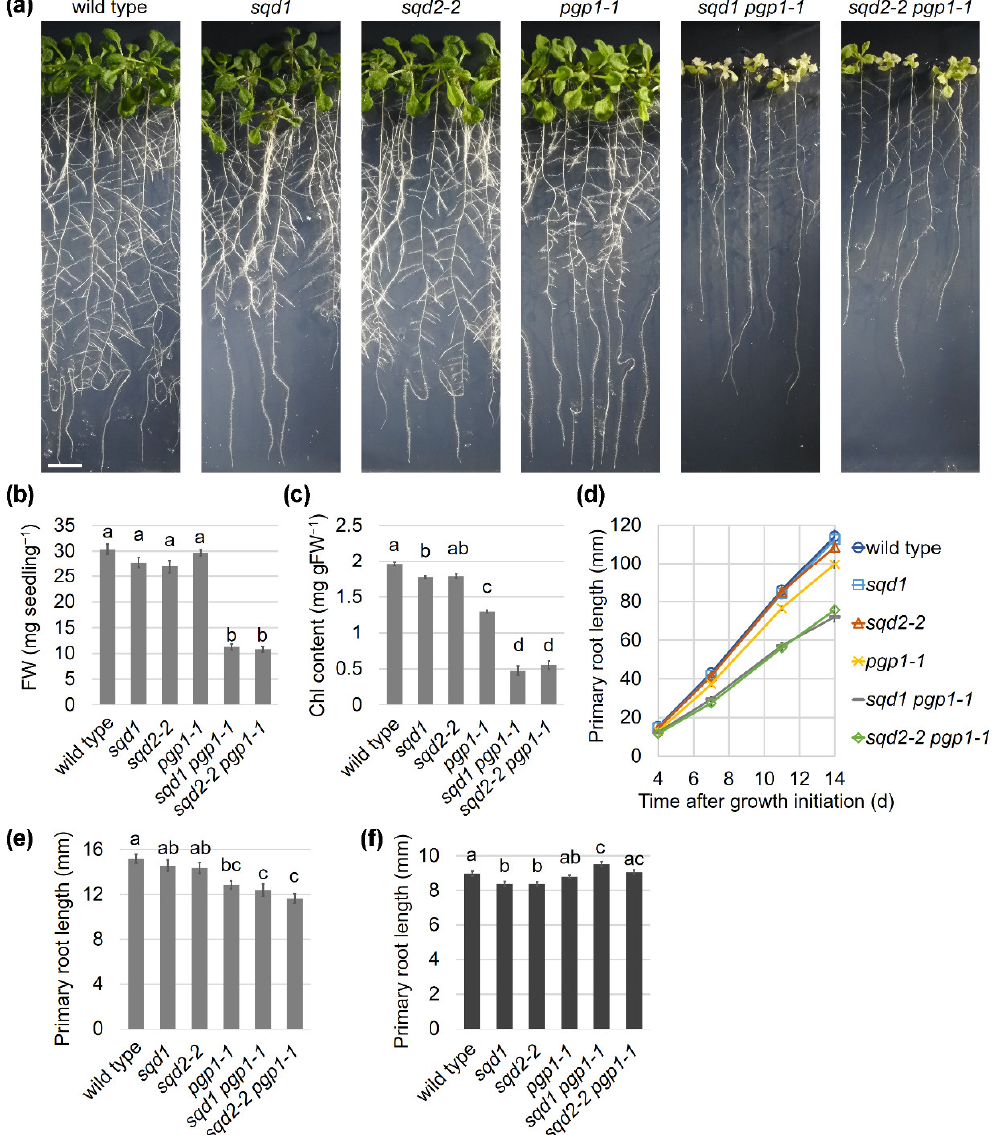
Figure 1. Comparison of growth characteristics of wild type and anionic lipid mutants. ( a ) Visible phenotypes of 14-day-old seedlings. All photographs are in the same scale (bar = 10 mm). ( b ) Fresh weight (FW) and ( c ) chlorophyll (Chl) content of the shoot of 14-day-old seedlings. Data are means ± SE of 24 independent samples. ( d ) Changes of primary root length during seedling growth under light. ( e ) Primary root length of 4-d-old seedlings grown under light. In ( d ) and ( e ), data are means ± SE of 36 seedlings. ( f ) Primary root length of 4-d-old seedlings grown under the dark condition. Data are means ± SE of 299, 290, 337, 359, 321, and 298 seedlings for wild type, sqd1 , sqd2-2 , pgp1-1 , sqd1 pgp1-1 , and sqd2-2 pgp1-1 , respectively. In ( b , c , e , f ), the lowercase letters indicate statistically significant differences between each line ( p < 0.05, Tukey’s post hoc honestly significant difference